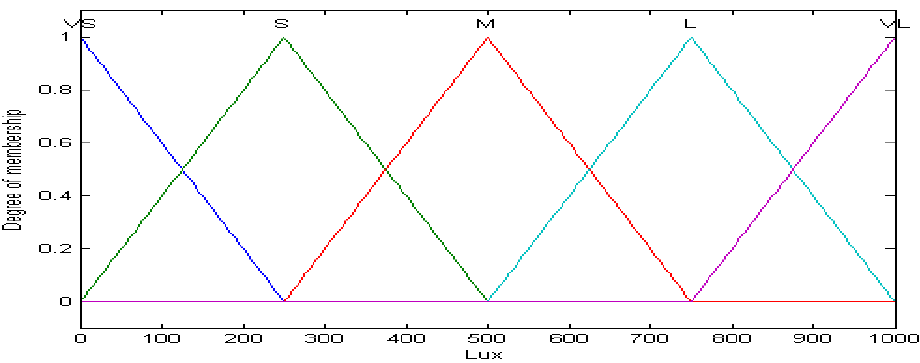
Figure 8. Membership functions of Lux .